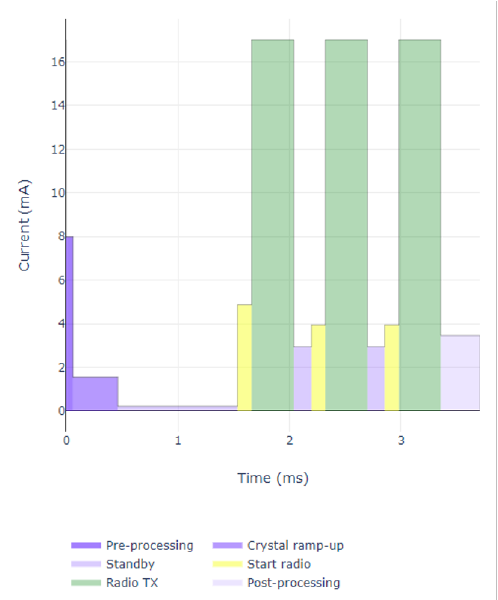
Figure 5. Projected current consumption made in Nordic Semiconductor’s power